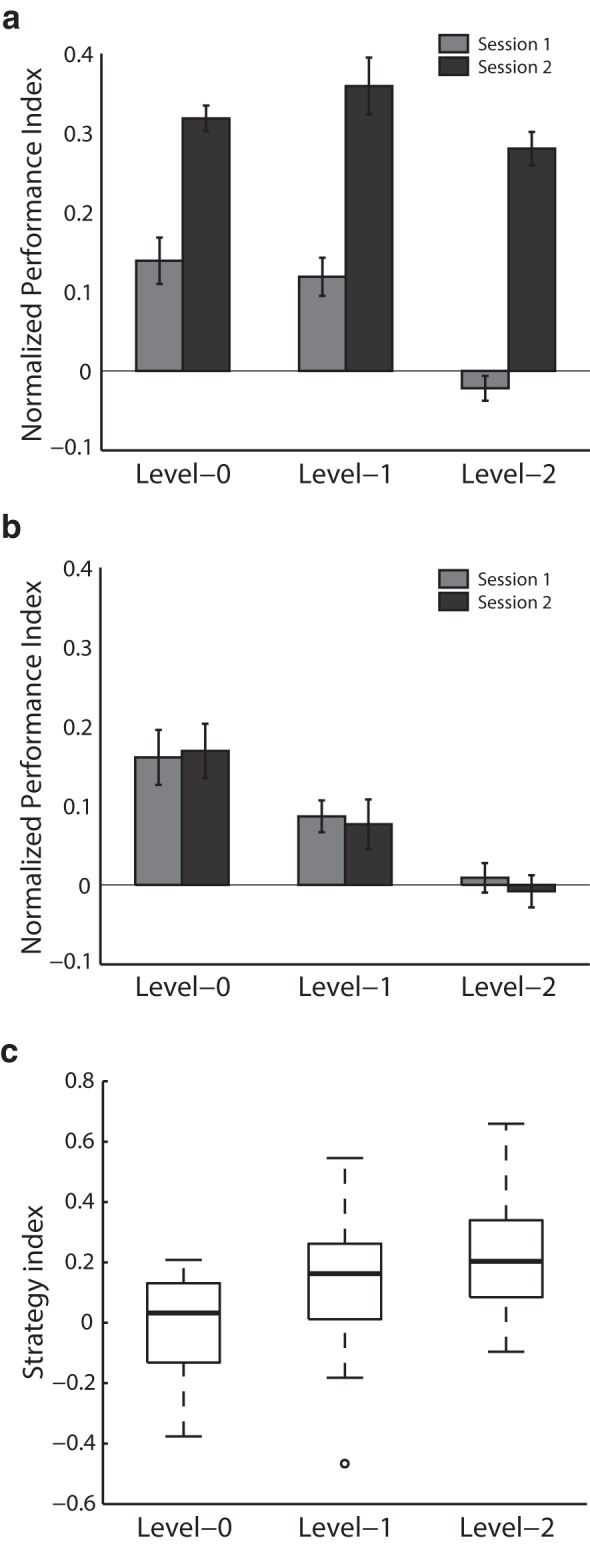
Behavioral performance. Mean normalized PI across participants per level during the first test session (gray bars) and second test session (black bars) for (A) the training group and (B) the no-training control group. Error bars indicate SEM across participants. C, Strategy index boxplots for level-0, level-1, and level-2 indicate individual variability for the training group. The upper and lower error bars display the minimum and maximum data values, and the central boxes represent the interquartile range (25th to 75th percentiles). The thick line in the central boxes represents the median. Open circles denote outliers.